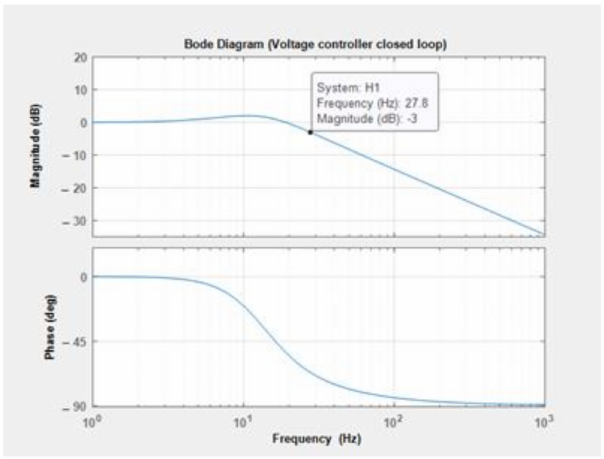
Figure 8. Bode plot of the closed loop outer voltage control